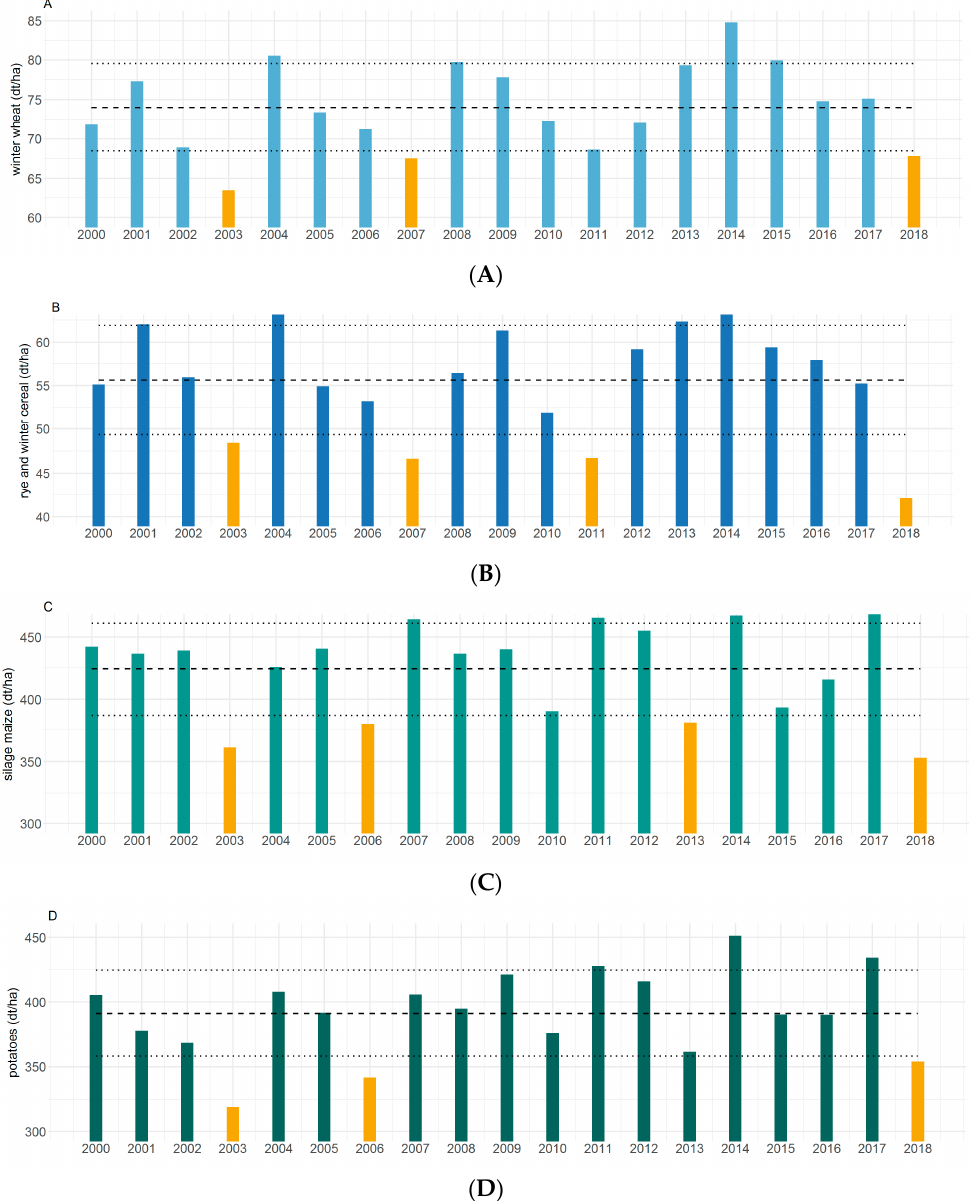
Figure 9. Yield statistics of Germany for the years 2000–2018 from the federal statistics office for four different crops [31]: winter wheat ( A ), rye and winter cereal ( B ), silage maize ( C ), and potatoes ( D ). The dashed line shows the mean yield and the dotted lines one standard deviation from the mean for the period of interest. Bars in orange are below the standard deviation. Be aware that the origin of the y-axis is non-zero in all four plots.